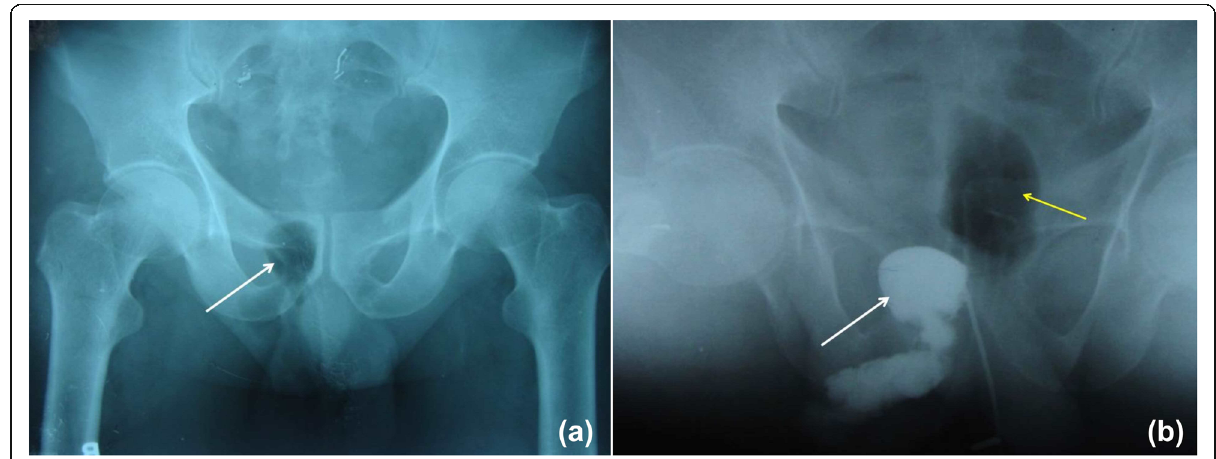
Fig. 2 a Plain X-ray pelvis (AP view) demonstrating gas shadow on the right perianal and gluteal region (white arrow). b X-ray fistulogram (Deshpande ’ s technique) of the same patient showing abscess cavity filled with radio-opaque contrast extending towards right gluteal region (white arrow) with gas-filled in the rectum (yellow